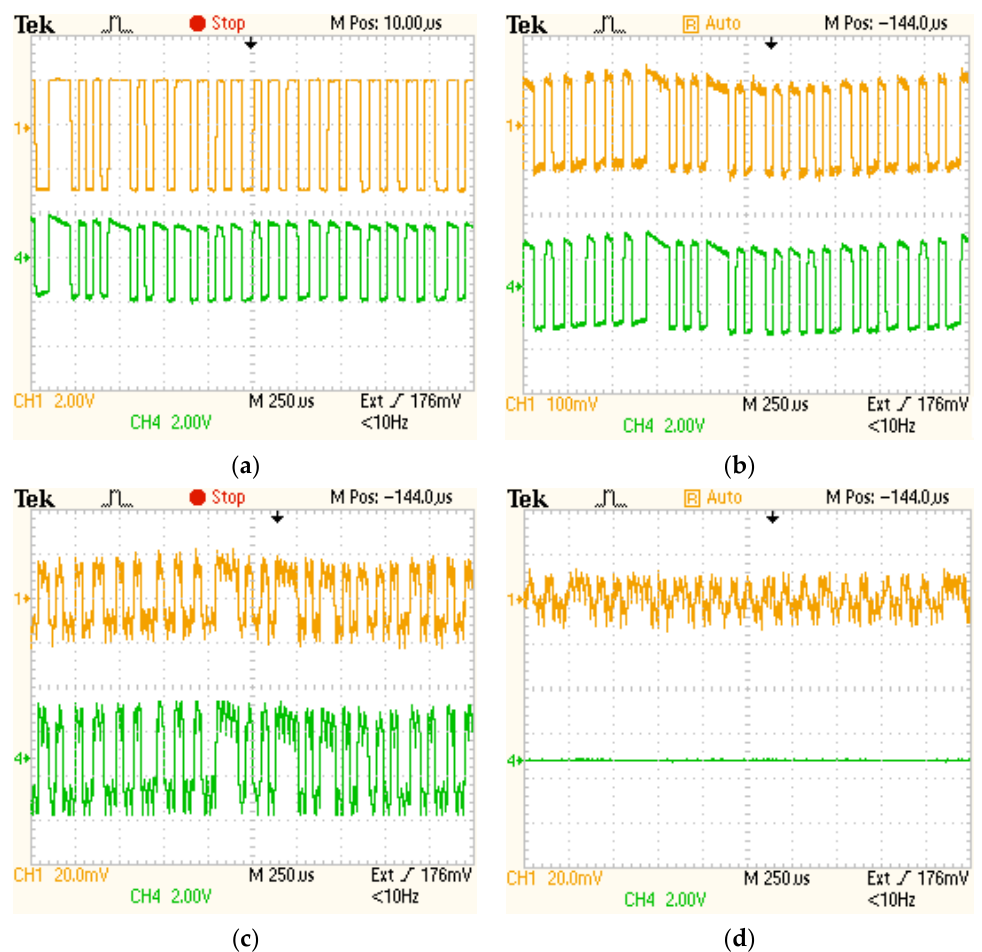
Figure 6. Comparative experimental evaluation showing the response of the logarithmic (Channel 1—orange) and of the linear (Channel 4—green) transimpedance circuits: ( a) . in dark conditions (no additional background light); ( b) . in high SNR conditions (incident noise irradiance of 200 μ W/cm 2 ); ( c) . in medium SNR conditions (incident noise irradiance of 1100 μ W/cm 2 ); and ( d) . in low SNR conditions (incident noise irradiance of 4500 μ W/cm 2 ). One can see that as the irradiance of the parasitic light is increasing, the logarithmic transimpedance circuit reduces its sensibility in order to prevent the photoelement saturation. On the other hand, the linear transimpedance circuit is saturated when the irradiance of the incident parasitic light increases above a certain limit. These experimental results confirm the benefits of the logarithmic transimpedance circuit.